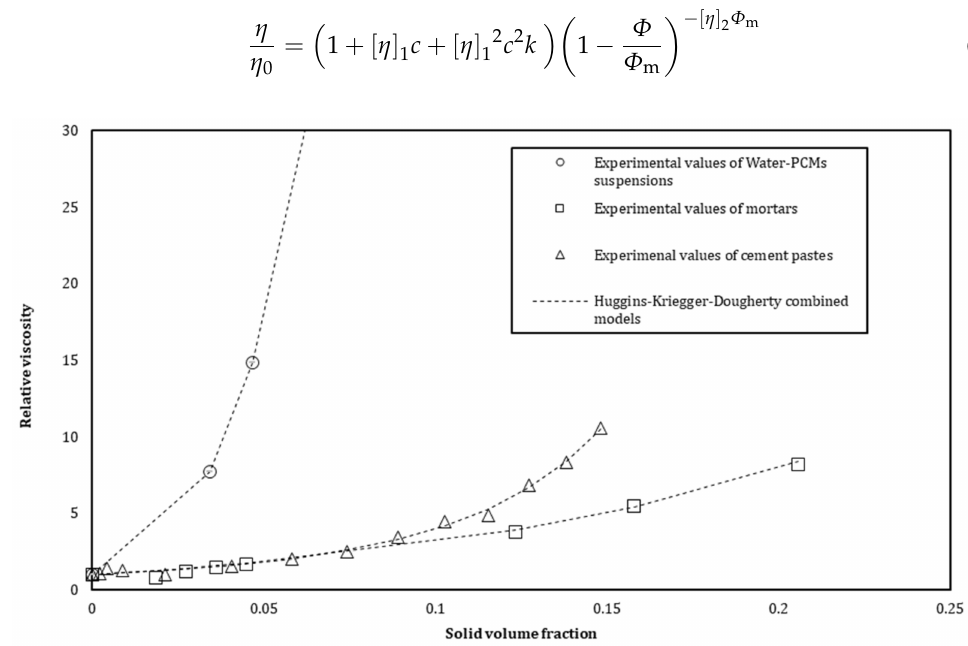
Figure 11. Relative viscosity as function of the solid volume fraction of s/s PCMs for cement pastes and